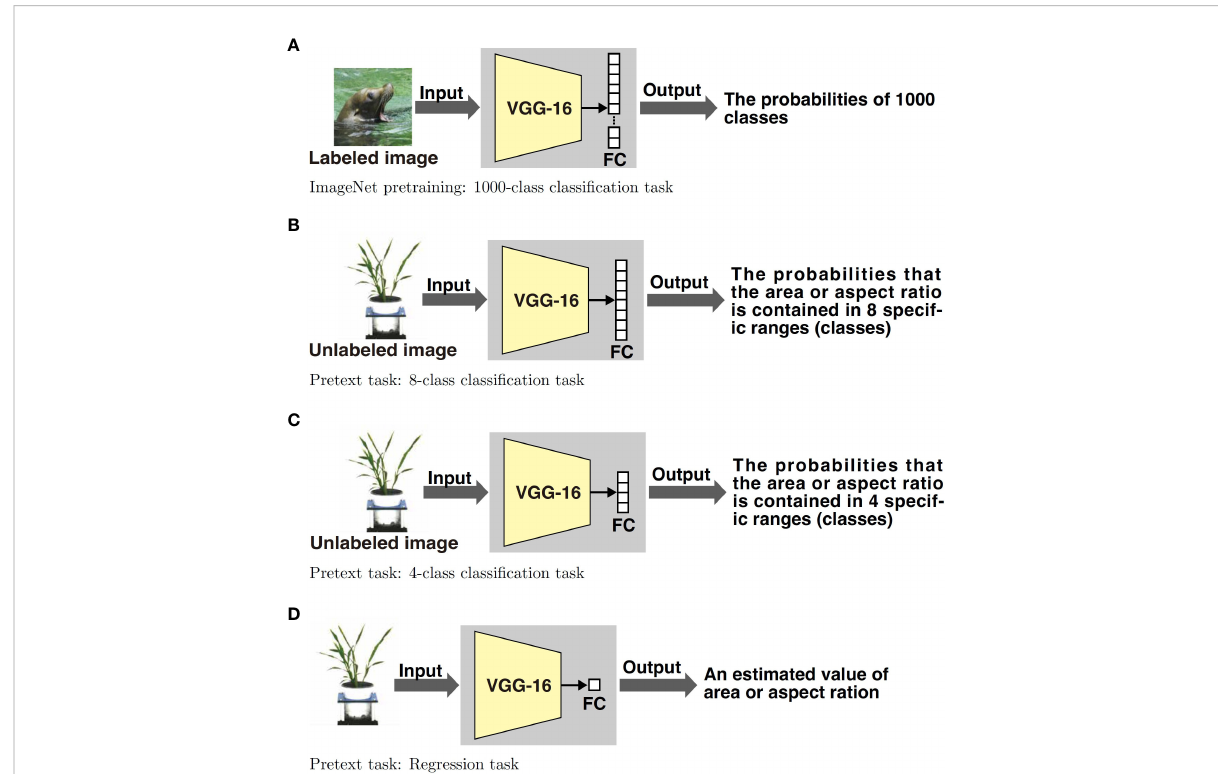
FIGURE 1 We use four feature training methods. Figure 1A shows a typical supervised training method, which uses the ImageNet dataset. The dataset consists of 1000 classes; thus the output layer (the last fully connected (FC) layer) of the network consists of 1000 elements. The DNN model is trained by updating the parameters in order to reduce the error between the output of the DNN and the ground truth. We use a pretraining model available on the web. Figures 1B – D show self-supervised methods using pretext tasks; they use 8-class classi fi cation, 4-class classi fi cation, and regression tasks. Hence, their last layers consist of eight, four, and one element, respectively. The pretext tasks in the proposed method estimate the area or aspect ratio of the plant within the input image. The images for training are unlabeled with the tiller numbers. The ground truth of the area and aspect ratio of the plant within the image are calculated by using image processing